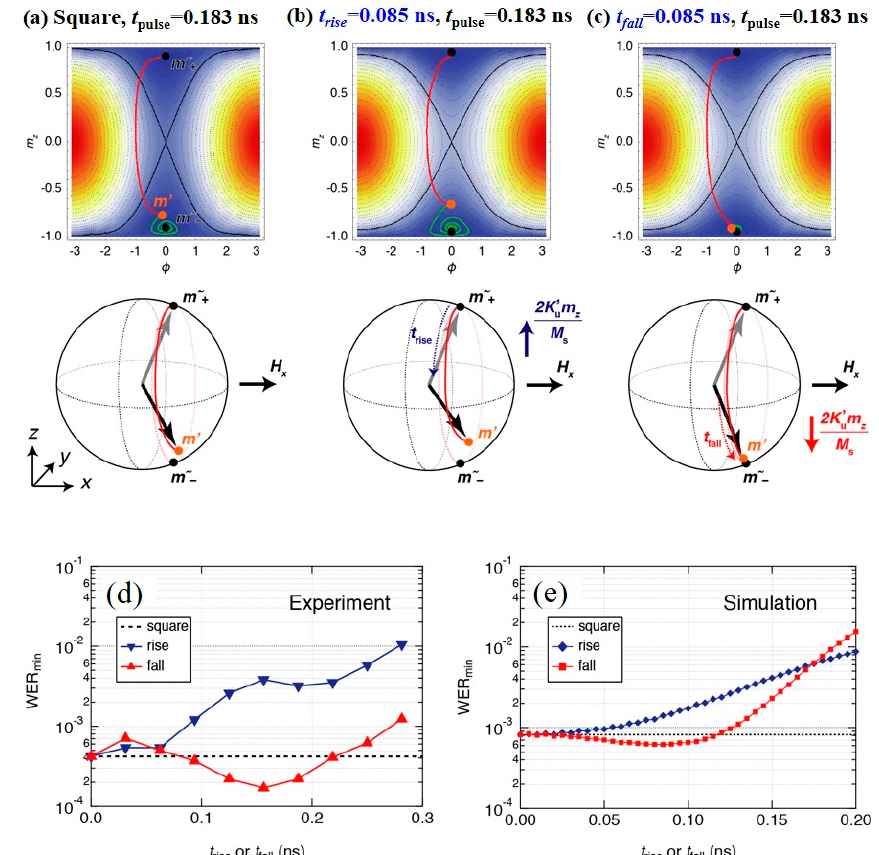
Figure 20. ( a )–( c ) Effects of pulse shaping on magnetization trajectory. The red and green lines represent the magnetization trajectory during and after application of the pulse, t pulse , respectively. ( d ), ( e ) WER minimum as a function of rise time (blue symbols) and fall time (red symbols). ( d ) experimental results; ( e ) numerical simulation results. Reprinted figure with permission from [108], Copyright 2019 by the American Physical Society.